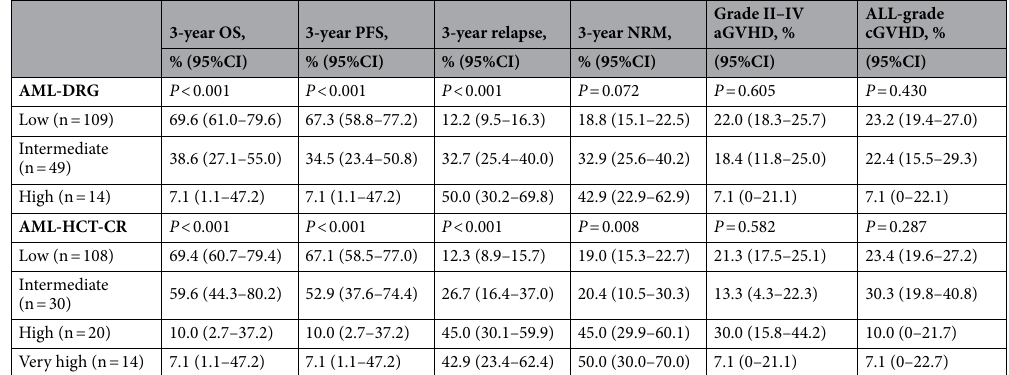
Table 2. Outcomes of AHCT according to the AML-DRG and AML-HCT-CR models. OS overall survival, PFS progression-free survival, NRM non-relapse mortality, aGVHD acute GVHD, cGVHD chronic GVHD.